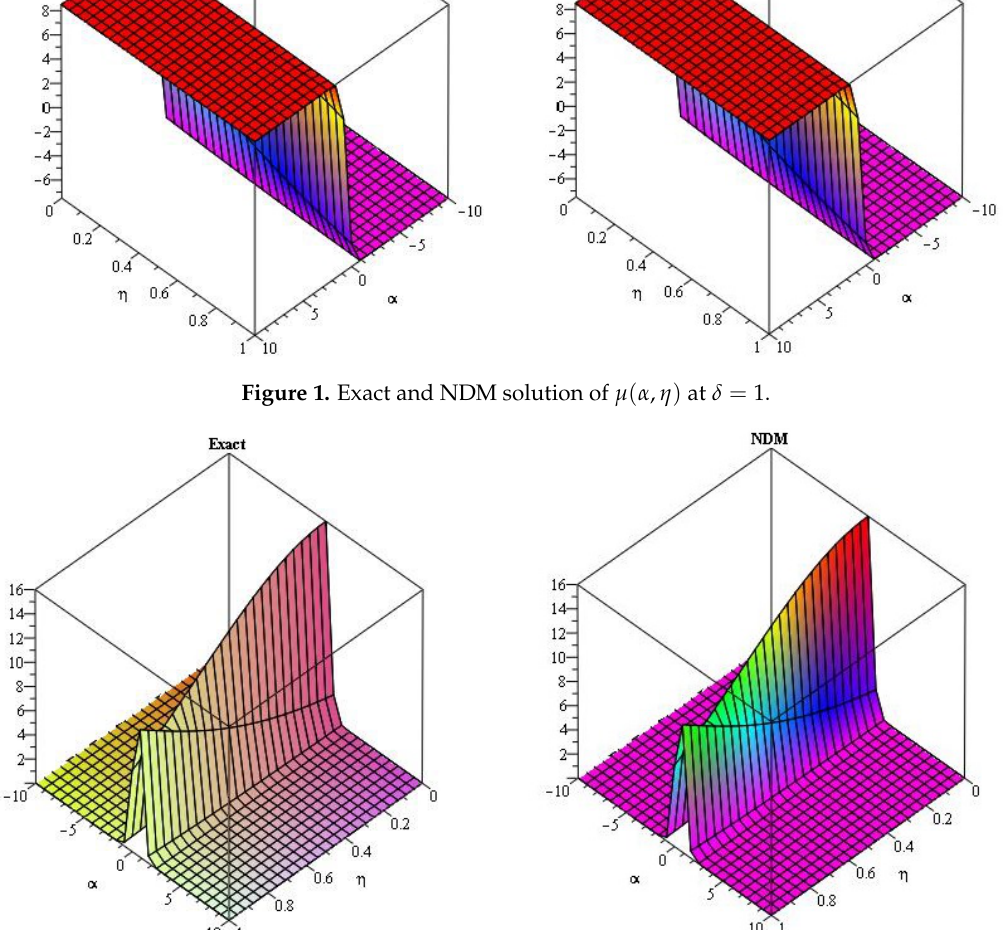
Figure 2. Exact and NDM solution of ν ( α , η ) at δ =